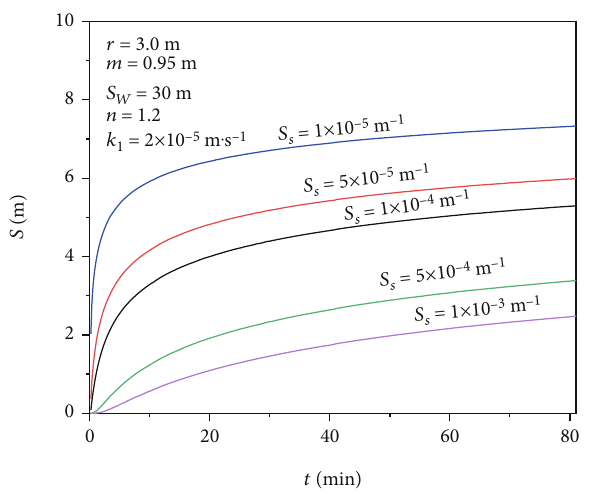
Figure 12: Hydraulic head in the aquifer ( r = 3 m) with m = 0 : 95 m, sw = 30 m, n = 1 : 2 , and k 1 = 2 × 10 − 5 m/s for the values of power index S s = 1 × 10 − 5 , 5 × 10 − 5 , 1 × 10 − 4 , 5 × 10 − 4 , and 1 × 10 − 3 m -1 ,